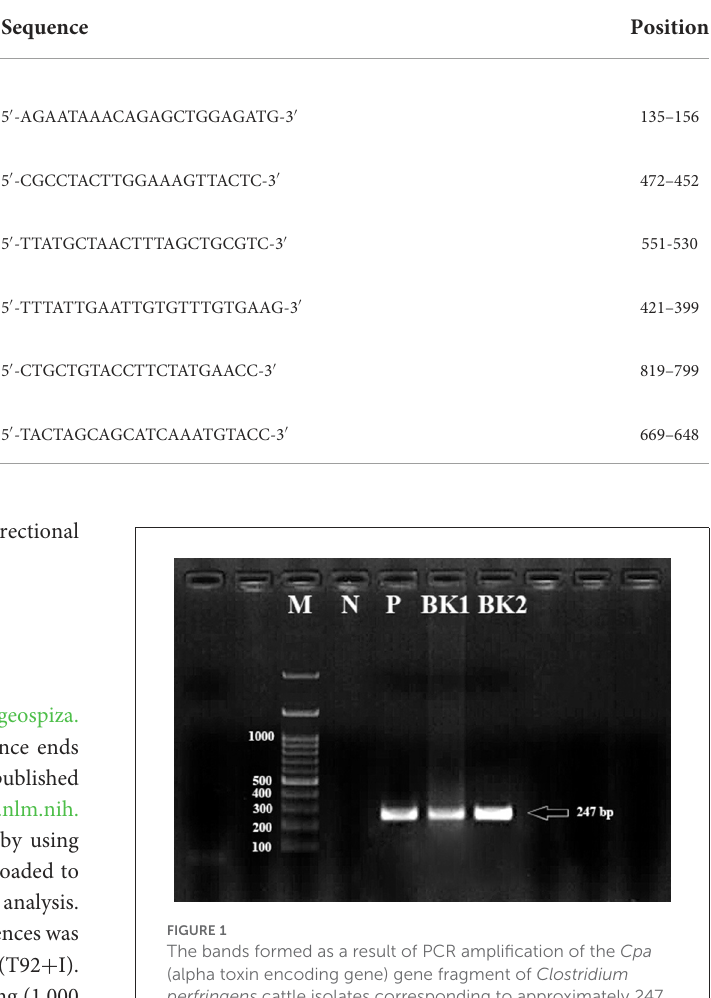
and KY038859) were used as reference sequences